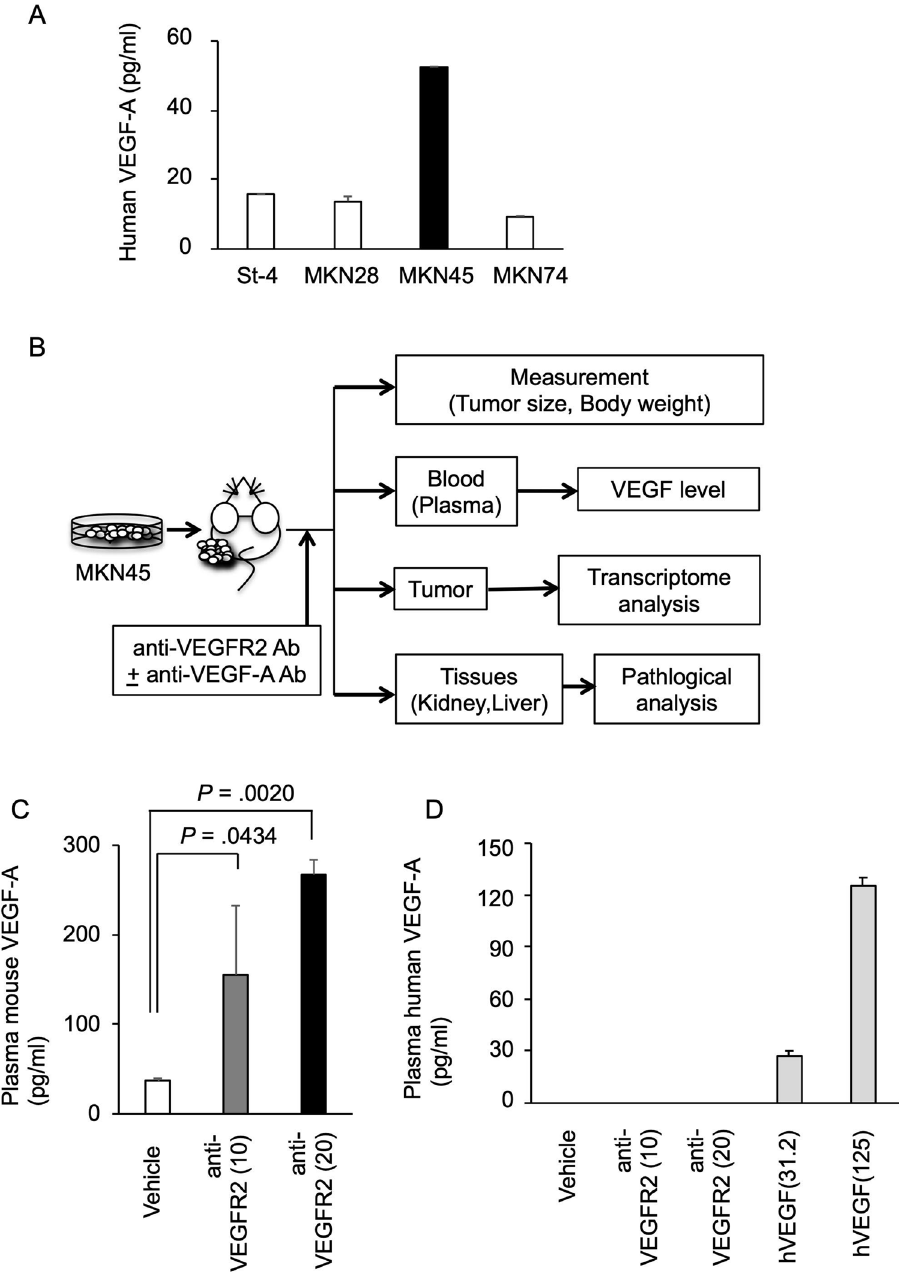
Figure 1. Elevated host-derived VEGF-A in the blood after VEGFR2-targeted therapy in a gastric cancer xenograft model. ( A ) Human VEGF-A levels secreted by human gastric cancer cell lines. Human gastric cancer cell lines were cultured for 72 h, and conditioned media were collected. Human VEGF-A level in the conditioned medium was measured as described in Materials and Methods. The VEGF-A concentrations normalized by cell number (per 1 × 10 4 cells) are shown. ( B ) Schematic diagram of the evaluation of plasma VEGF levels and therapeutic effect of VEGFR2 and VEGF-A dual targeting in a gastric cancer xenograft model. ( C , D ) Alterations in murine ( C ) and human ( D ) VEGF-A levels in mouse plasma following anti-mouse VEGFR2 antibody administration were shown. BALB/c nude mice were subcutaneously injected with 3 × 10 6 MKN45 cells. When the tumor reached 100–200 mm 3 , mice were intraperitoneally treated with vehicle (PBS) or an anti-mouse VEGFR2 antibody (DC101) (10 or 20 mg/kg) twice a week for 2 weeks (N = 3). At 14 days after the start of treatment, mouse plasma was collected, and human and murine VEGF-A concentrations were measured as described in Materials and Methods. For the estimation of human VEGF-A levels, purified human VEGF-A protein solutions (hVEGF, 31.2 and 125 pg/ml) were also tested as controls. Statistical significance was evaluated by ANOVA, followed by the Tukey–Kramer post-hoc test. The figures were generated by Microsoft Powerpoint (16.16.27) (https:// www. micro soft. com/ ja- jp/ micro soft- 365/ power